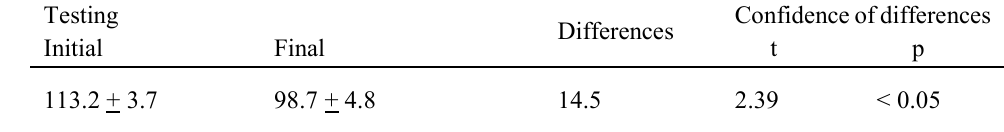
Table 2. Duration of diseases (in days) (M+m, %) Testing